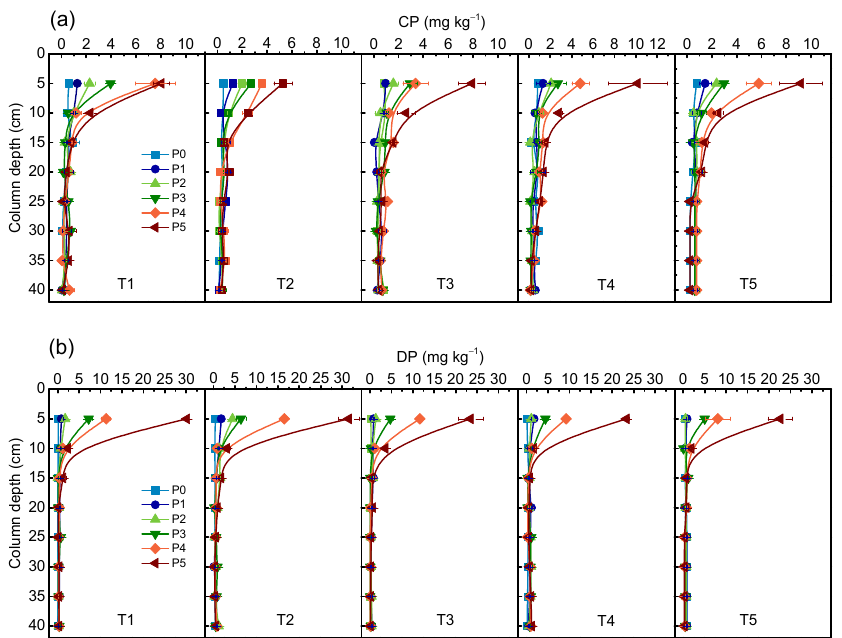
Figure 5. Distribution of colloidal phosphorus (CP) ( a ) and dissolved phosphorus (DP) ( b ) in soil profiles at different treatments. Phosphorus fertilizer levels at 0 (P0), 20 (P1), 40 (P2), 100 (P3), 200 (P4), and 400 (P5) mg kg − 1 , respectively, and the soil columns were conducted at 7 days (T1), 14 days (T2), 21 days (T3), 28 days (T4), and 56 days (T5).